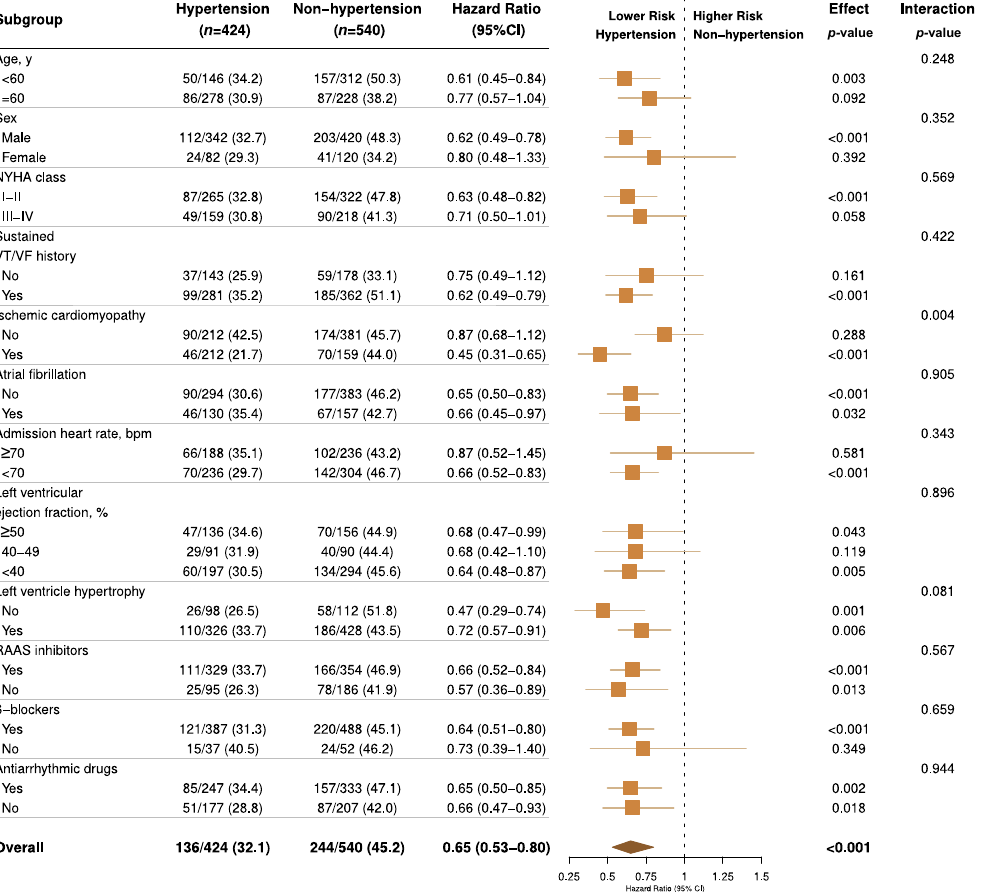
Figure 5. Restricted cubic spline plots for primary outcome by systolic blood pressure (SBP).